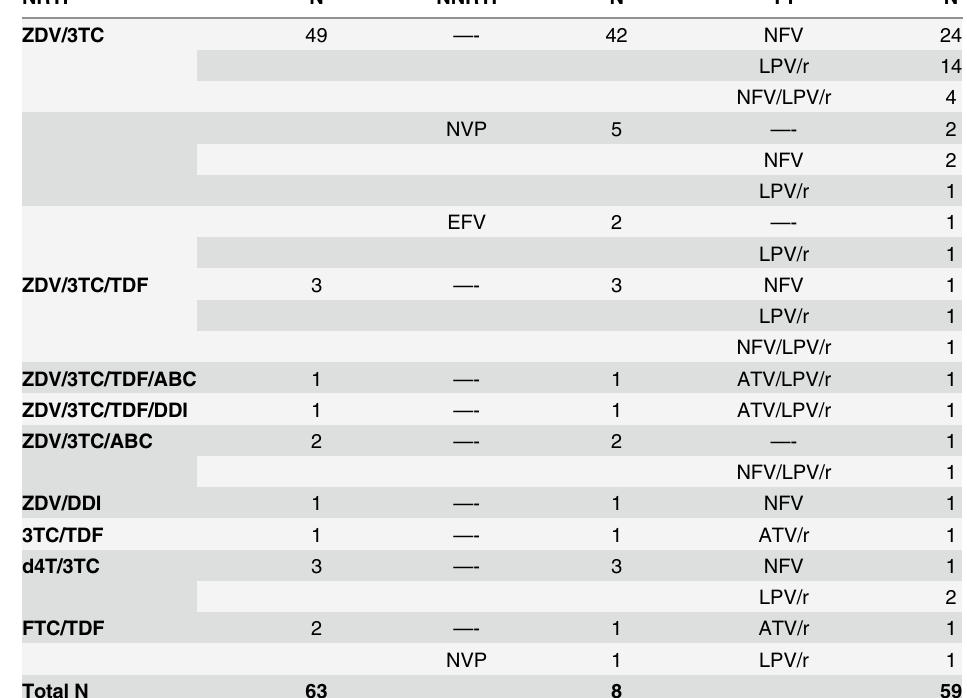
Table 3. Combination antiretroviral therapy regimens taken during pregnancy by HIV positive study cohort (n = 63). NRTI